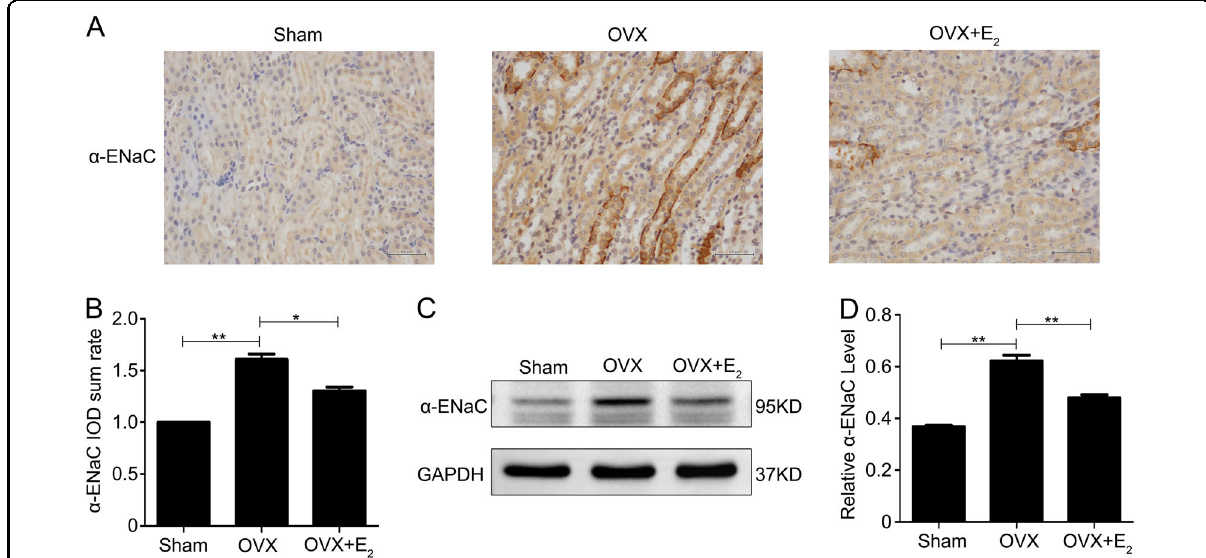
Fig. 2 Estrogen de fi ciency increases the expression of α -ENaC in the kidneys of rats. a The expression of α -ENaC protein in kidney tissues of rats subjected to different treatments was detected by immunohistochemical staining. b Quanti fi cation of the positive staining for the α -ENaC protein in ( a ). c Western blot analysis was performed to con fi rm the expression of α -ENaC in kidney lysates from the different treatment groups. d The intensity of the α -ENaC protein bands was analyzed by densitometry as in c and normalized to the GAPDH level. The bars are the means ± SE values from three independent experiments. *P < 0.05 and **P <